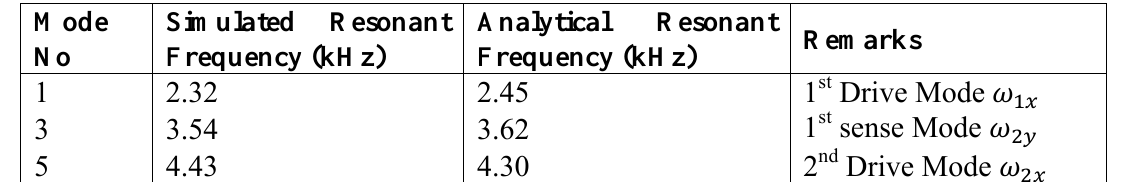
Table 1. Comparison of Simulated and analytical results for natural frequencies for drive and sense